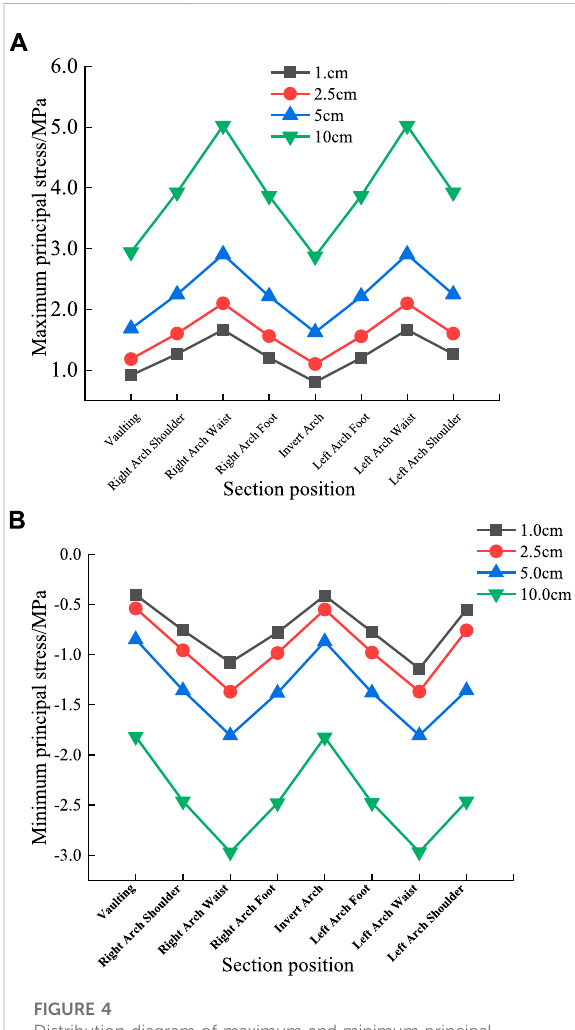
FIGURE 4 Distribution diagram of maximum and minimum principal stresses under elastic constitutive conditions. (A) Elastic model lining section maximum principal stress; (B) Elastic model lining section Minimum principal stress. FIGURE 5